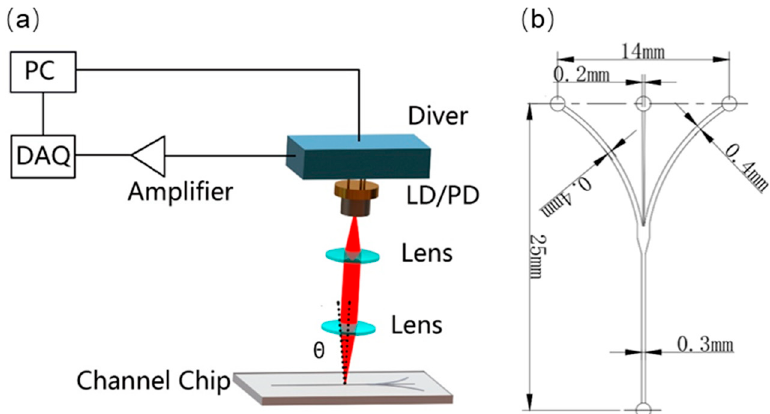
Figure 3. The schematic graphs of the system. ( a ) The optofluidic flow cytometry system. ( b ) The hydrodynamic channel